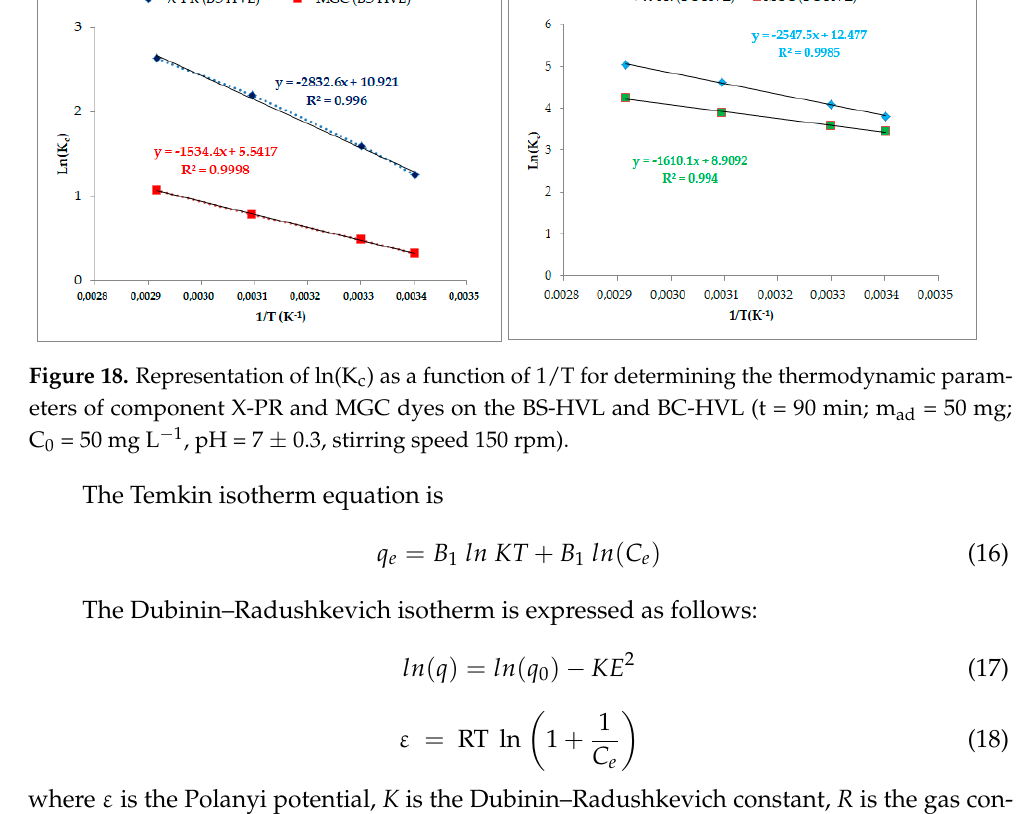
Table 5. Thermodynamic parameters for the adsorption of X-PR and MGC onto BS-HVL and BC-